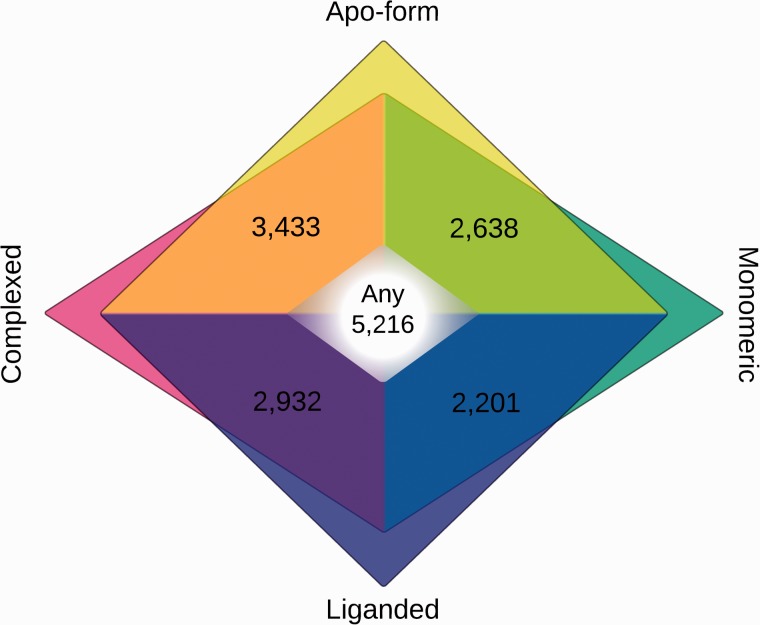
Venn diagram of number of alignments according to conformational state of templates. Alignments in apo-form are in yellow tones; liganded in blue tones; monomeric in teal and complexed in magenta. State-free alignments, where templates can be in any state, are shown in the white centre.